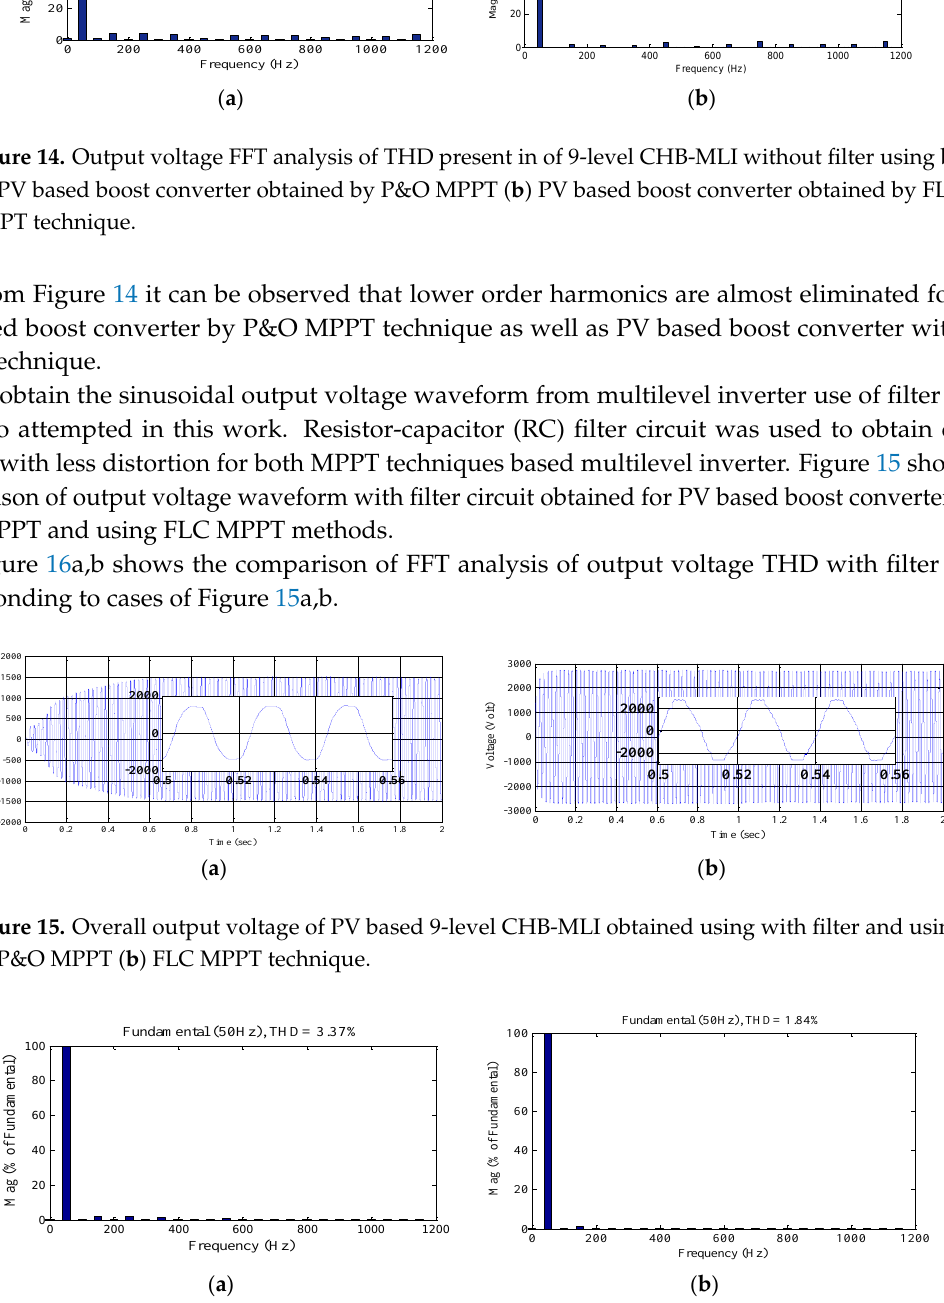
Figure 13. Overall output voltage of 9-level CHB-MLI without filter for ( a ) PV based boost converter obtained by P&O MPPT method ( b ) PV based boost converter obtained by FLC MPPT technique.